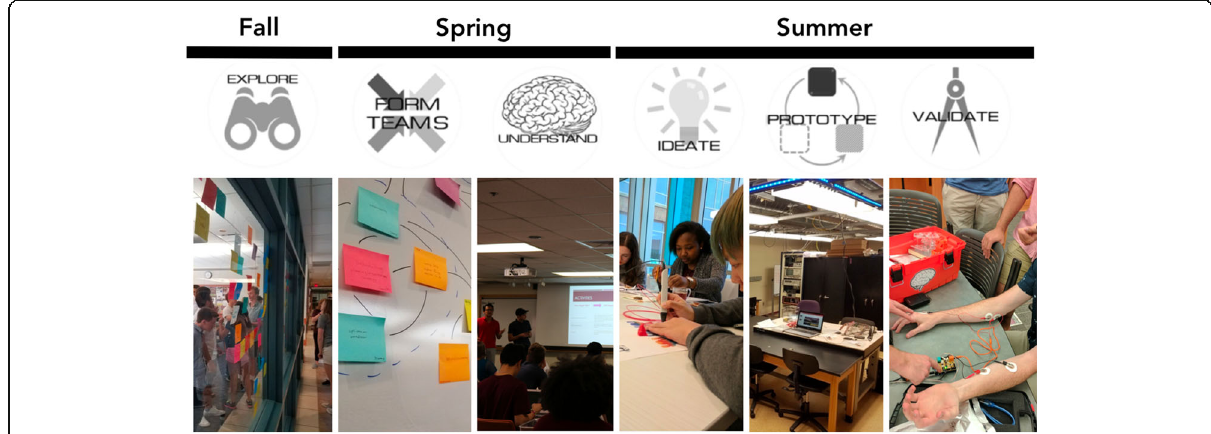
Fig. 4 Example activities from VIX process. Students start by exploring their interests. This can be done by writing out their interest in post-it notes and displaying them along with their peers ’ interests. Next, students form teams by exploring the similarities in their interests. Understanding their project through research is the next step. This is followed by ideating their approaches, prototyping their proposed solution in a physical space, and finally validating their solution through